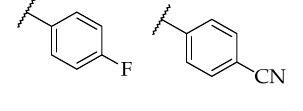
Figure 30. SARs of Mannich bases of 1-(N-substituted amino)methyl-2-ethylbenz–imidazoles. In 2010, Figure 29. SARs of 3,5-disubstituted isoxazole at N1 of benzimidazole. Mariappan and his co-researchers, in 2011, studied the anti-inflammatory activity of a few Mannich bases of 1-( N -substituted amino)methyl-2-ethylbenzimidazoles in mice with carrageenan-induced rat paw oedema. The amount of compound administered was 100 mg/kg p.o. Compounds with 4-fluoro or bromo substituted aniline at R (Figure 30) showed substantial anti-inflammatory effects, with 23 and 25% inhibition of rat paw oe- dema. Moreover, 2- or 3-halogenated aniline was conducive to anti-inflammatory activ- ity; this may be due to steric hindrance. Overall, electron-withdrawing groups with lip- ophilicity were preferable for activity [48]. The SARs of the compounds are shown in Figure 30.